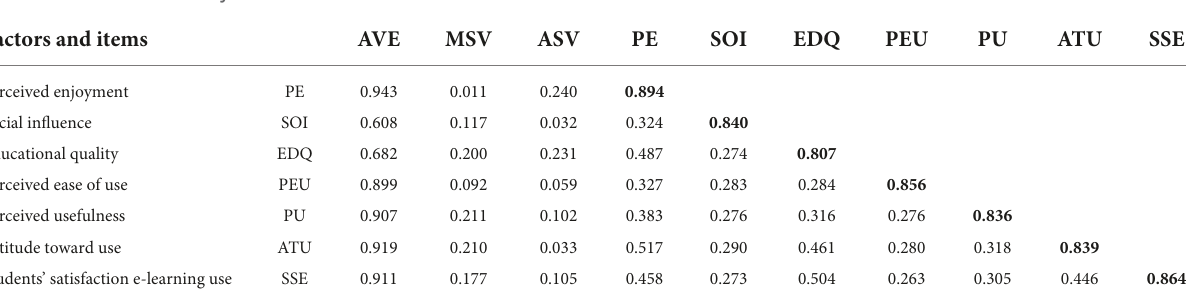
TABLE 4 Discriminant validity.